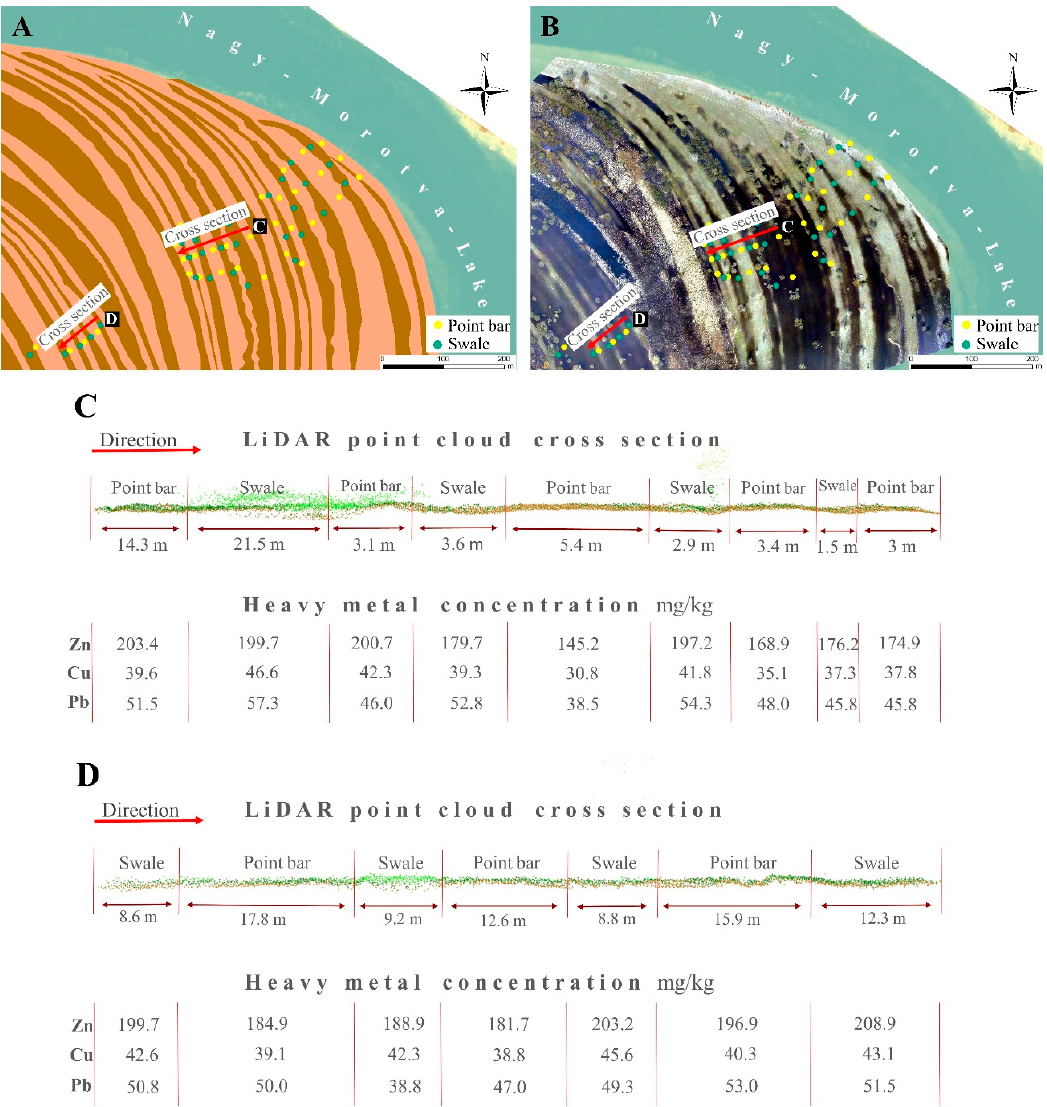
Figure 5. Point bar and swale topography, and their heavy metal accumulation pattern. ( A ) The digitized fluvial forms in a LiDAR-based digital terrain model; ( B ) point bar-swale series in an aerial image during flood; ( C , D ) cross sections of point bars and swales in a LiDAR point cloud (z exaggeration: 2) and their metal concentrations. When point bars have denser vegetation and they are in lower position their metal concentrations were higher, as it reflected in case of Figure 5C in the first two point bars.